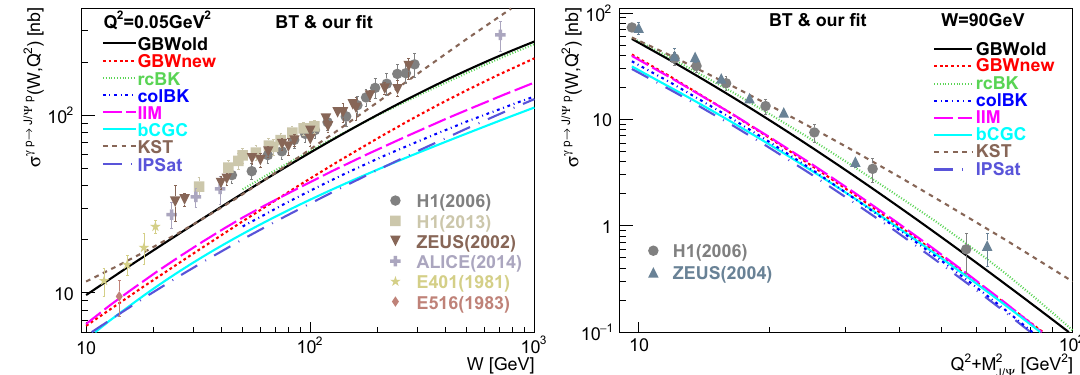
Fig. 14 The same as Fig. 7 but for different phenomenological dipole cross sections described in Sect. 4